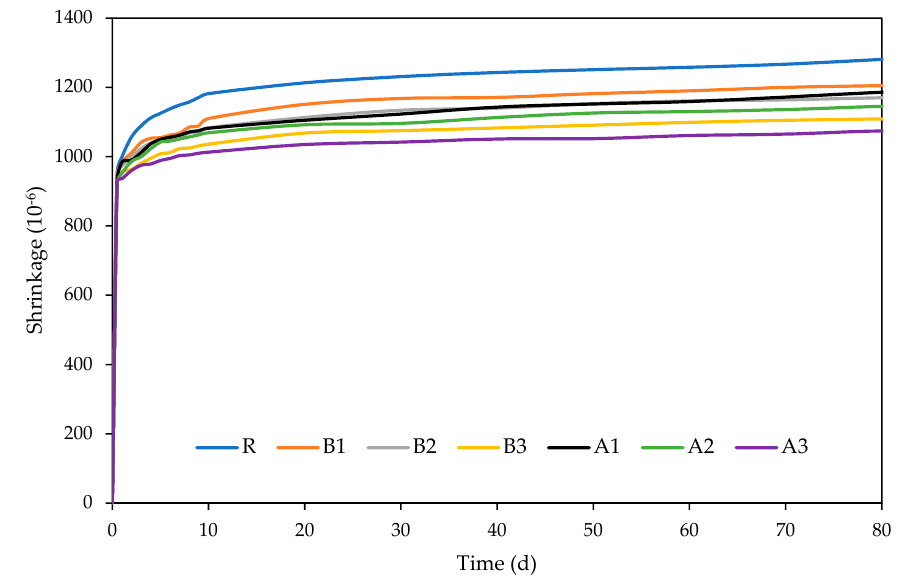
Figure 7. Shrinkage development of studied cement mortars.